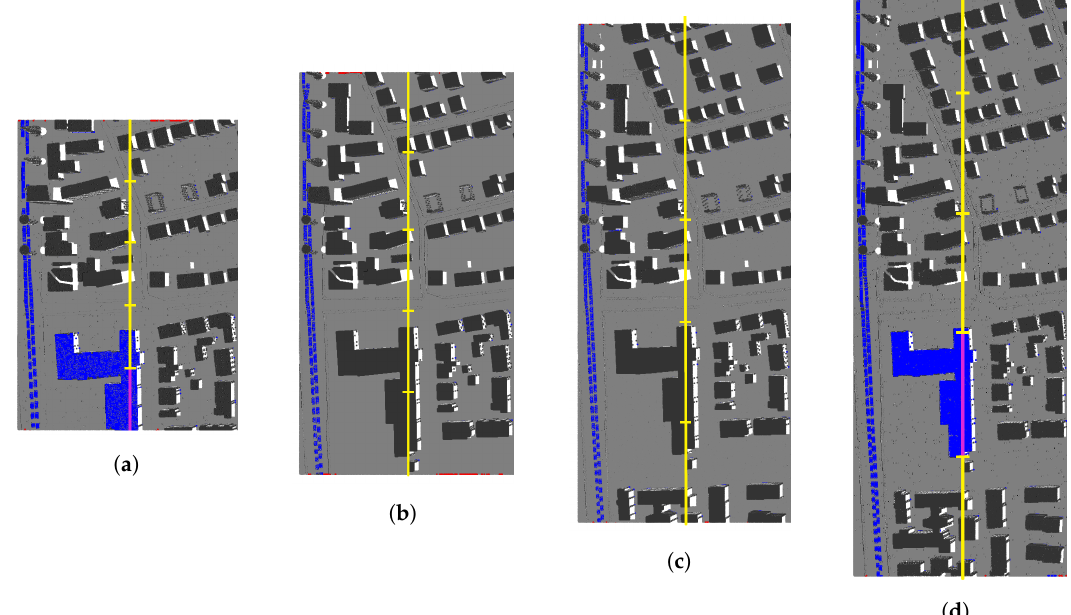
Figure 20. Segments distribution (yellow) of a scan line for different scan-line lengths: ( a ) 300, ( b ) 400, ( c ) 500, and ( d ) 600: Scan-line segments fully covered by the building are highlighted in